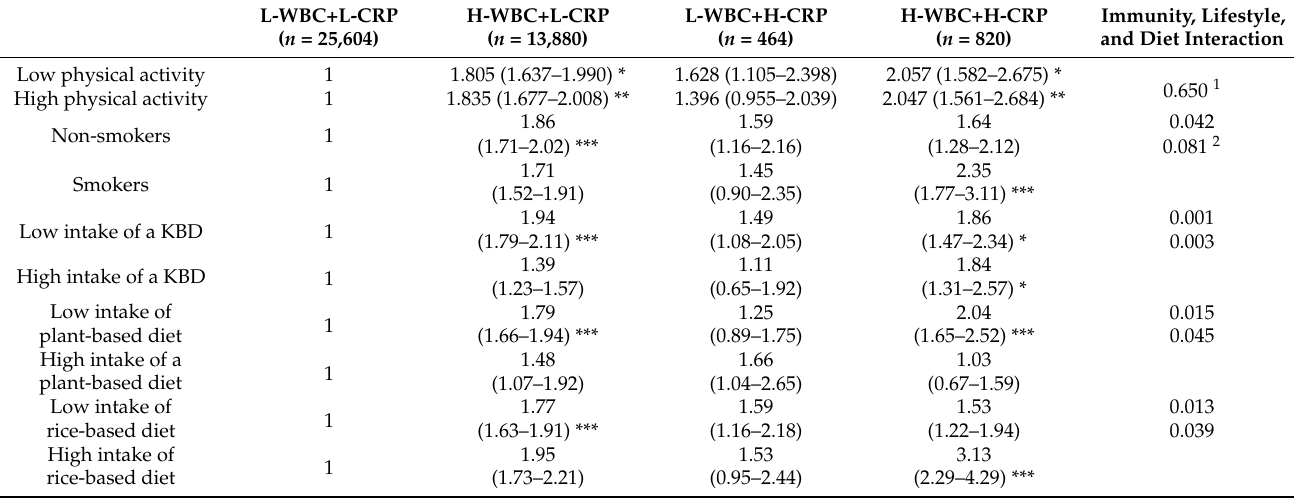
Table 5. Innate immunity and diet/lifestyle interaction and adjusted odds ratio of metabolic syndrome-related parameters in the low- and high-intake of diet patterns after covariate adjustments.